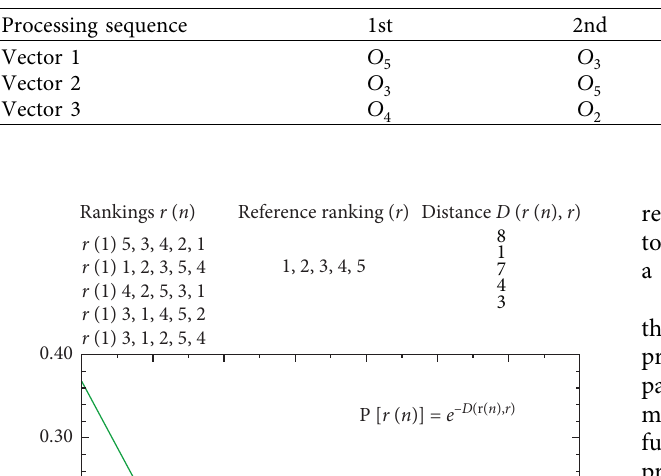
Table 3: Members of the population as permutations.